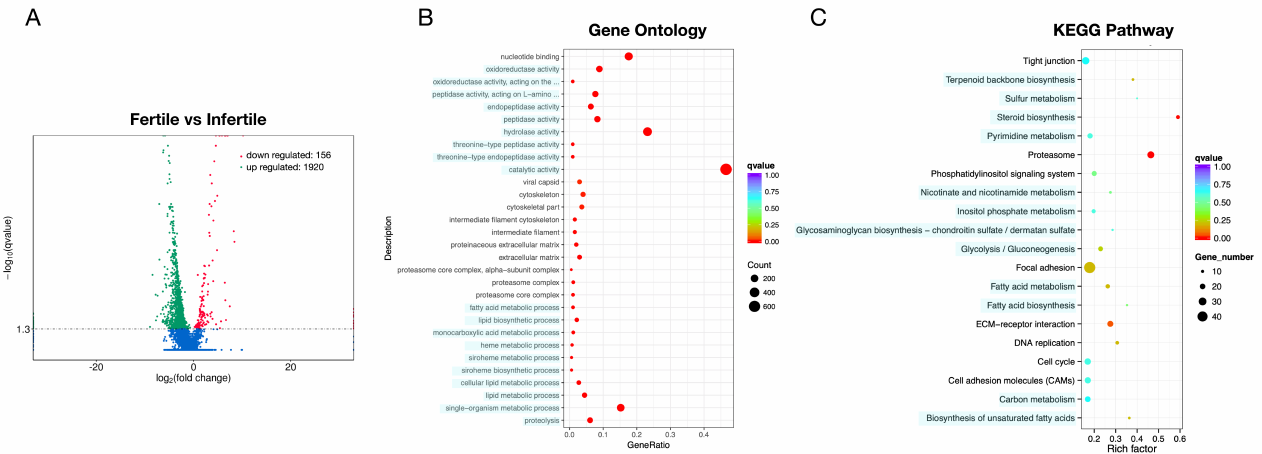
Figure 2. Volcano plot and Gene Ontology (GO)/pathway analysis of differentially expressed (DE) microRNAs (mRNAs) between infertile and fertile group in Paralichthys olivaceus . ( A ) Volcano plot of DE mRNAs. The red spots, green spots, and blue spots separately represent down-regulated, up-regulated, and undifferentiated mRNAs. ( B ) Histogram of Gene Ontology (GO) enrichment of mRNAs. ( C ) Top 20 significantly changed mRNA